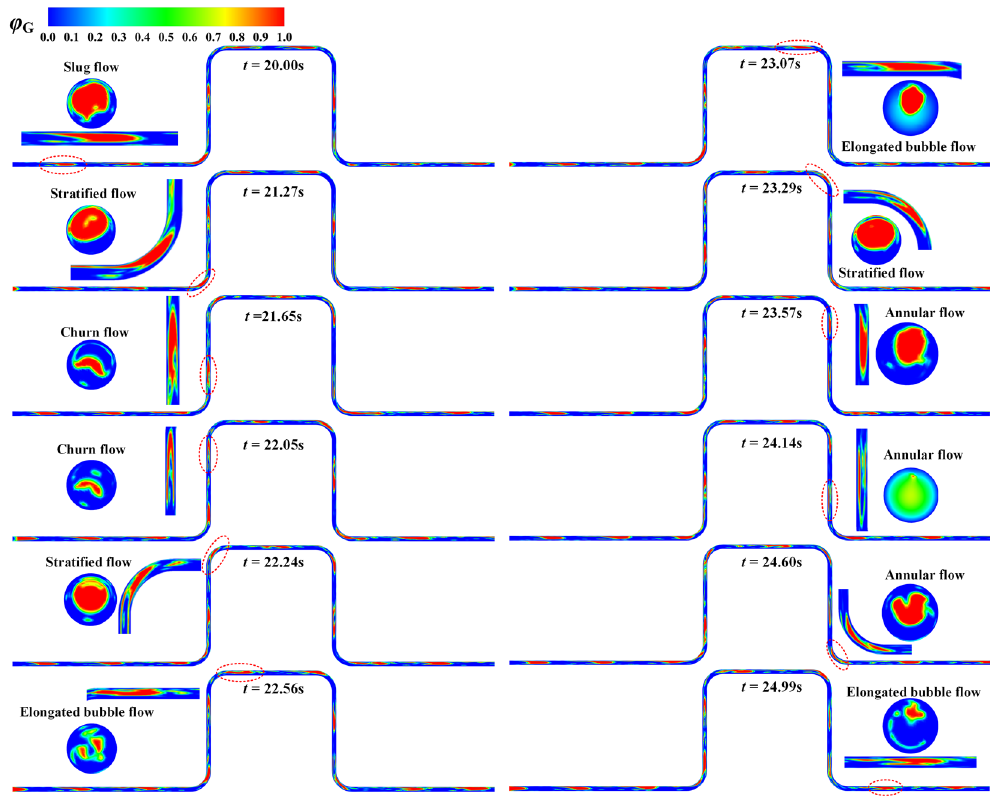
Figure 9. Spatial evolution of a gas plug that is injected from the inlet passing through the jumper in the case of Q G = 6 kg/s and Q L = 144 kg/s. m-in m-in